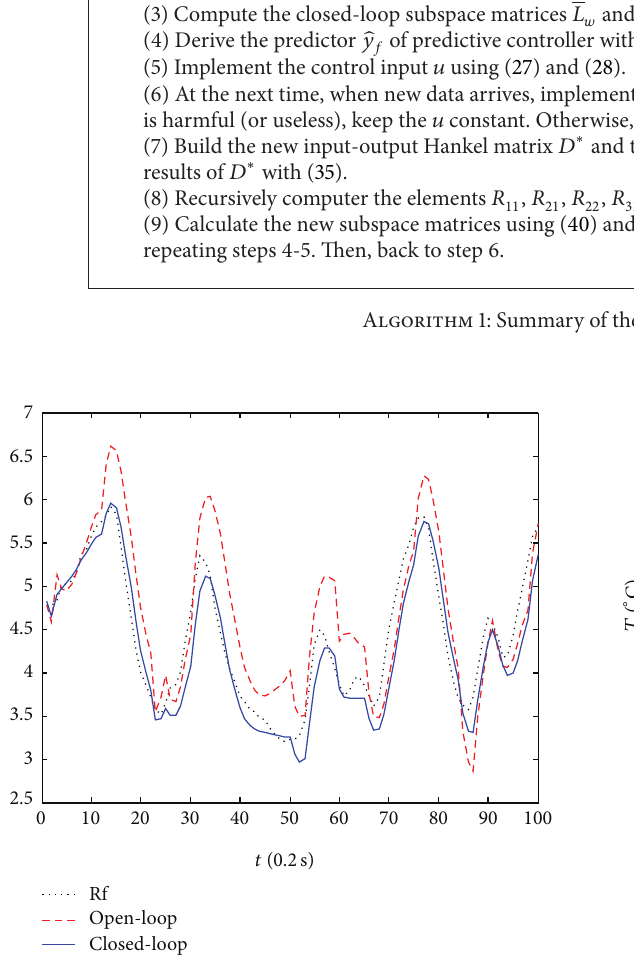
Figure 2: The response of the identified model and process output. Figure 3: The output 𝑇 tracking